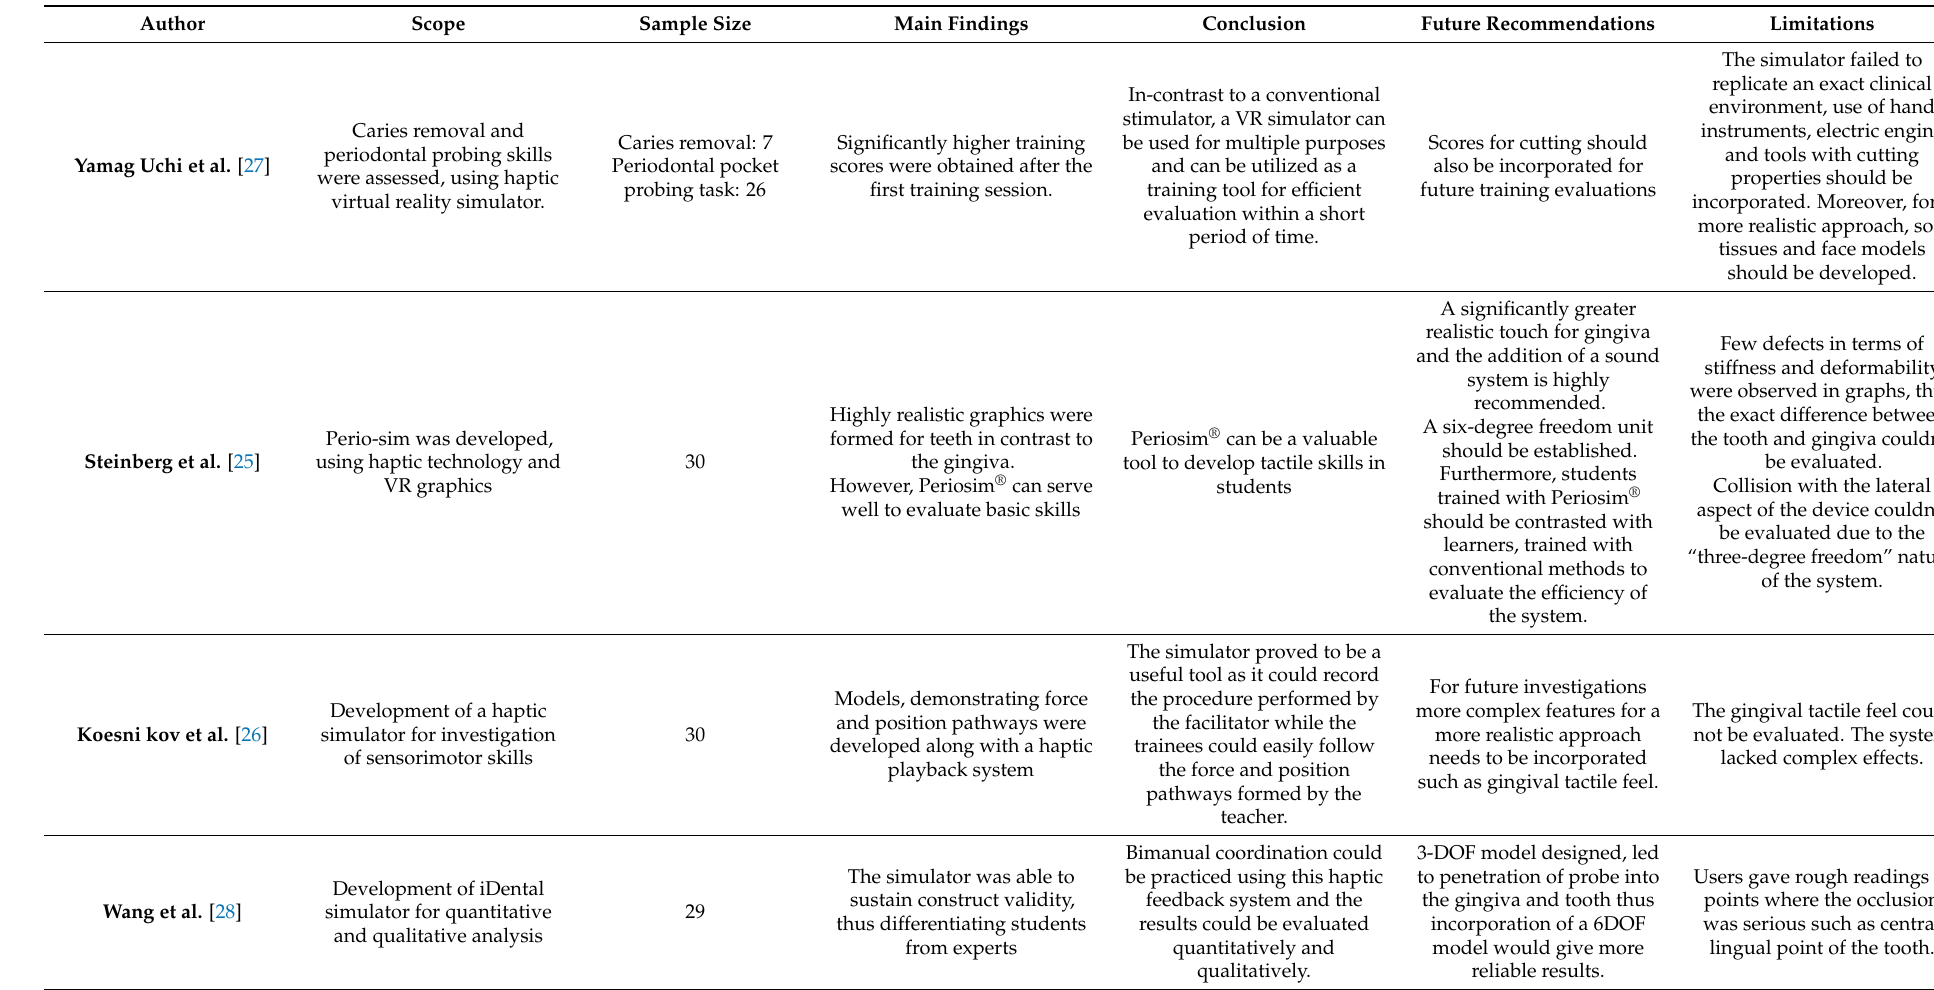
Table 2. Applications of virtual reality (VR) simulation in